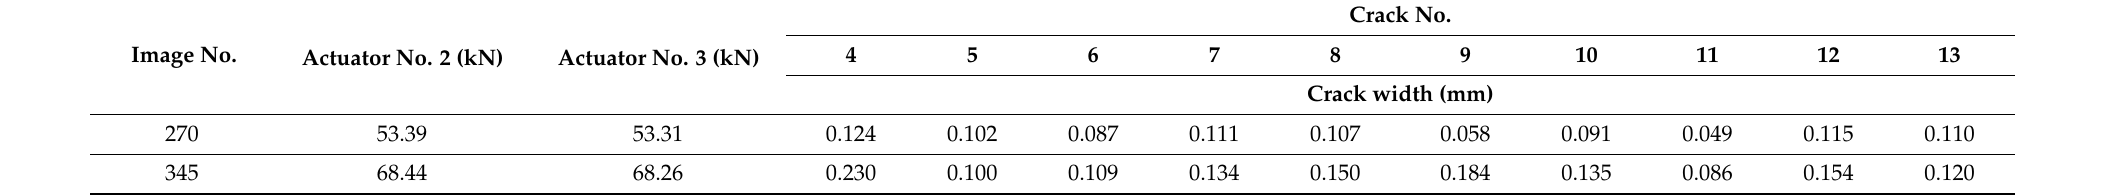
Table 8. Crack width results for beam A2M-2 at 0.75 and 0.95 of the actual damage force.